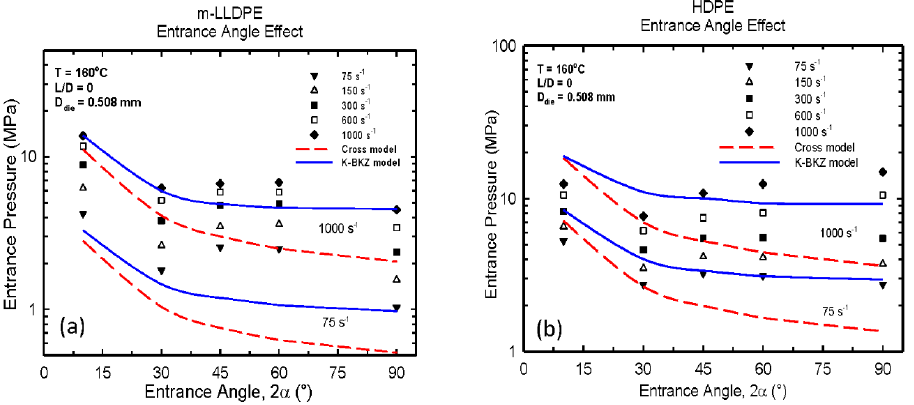
158 Figure 2. The entrance pressure of ( a ) LLDPE ( b ) HDPE and ( c ) LDPE at 160 o C as a function of 159 contraction angle at various values of apparent shear